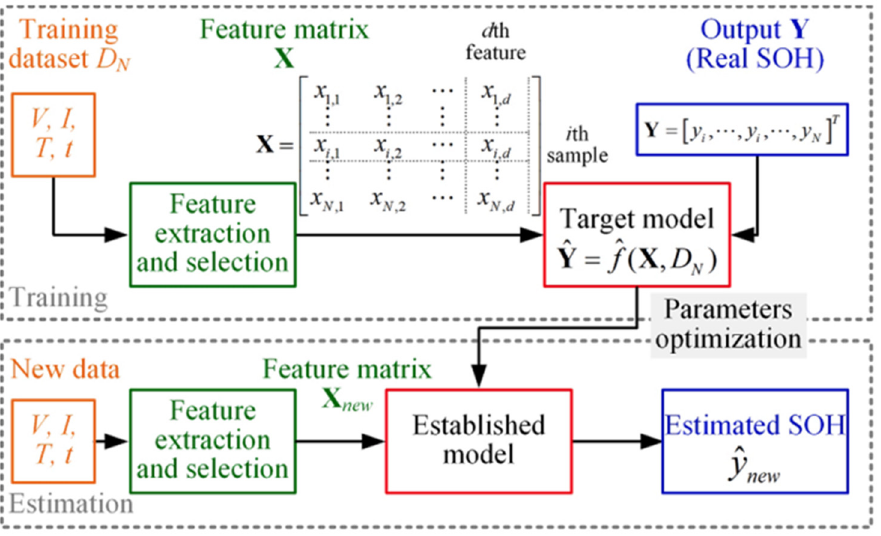
Figure 6. The battery SOH estimation structure using ML algorithms [61].